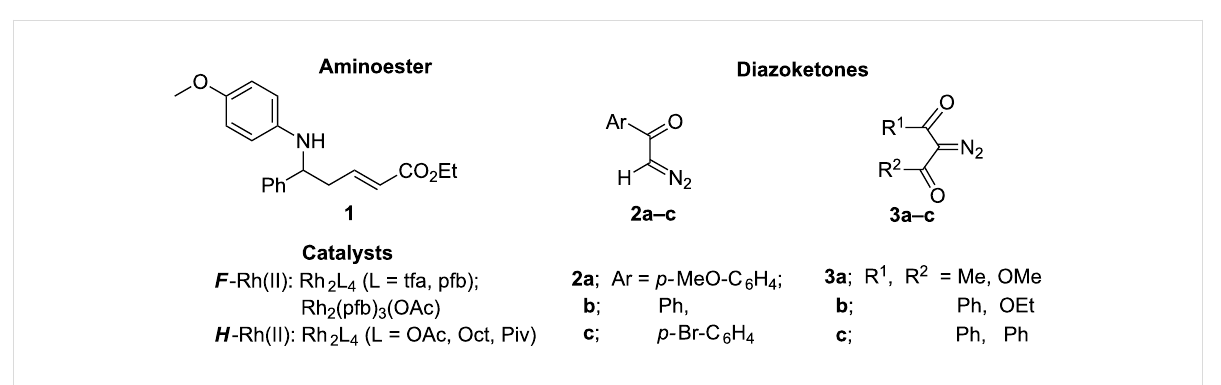
Figure 1: The structures of the starting compounds 1 – 3 and catalysts used in this